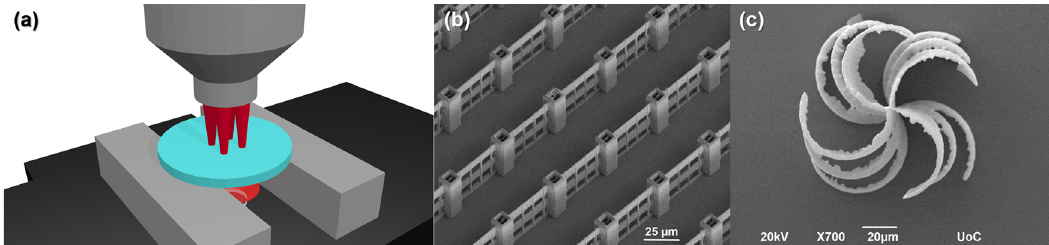
Figure 8: (a) – A depiction of multi-focus illumination after the magni fi cation objective. Reprinted with modi fi cation from [130]. (b) – 3D microstructures fabricated in parallel using 9 × 9 beamlets created by a fi xed DOE. Reprinted with permission from [126]. (c) – A 3D object printed holographically. Reprinted with permission from